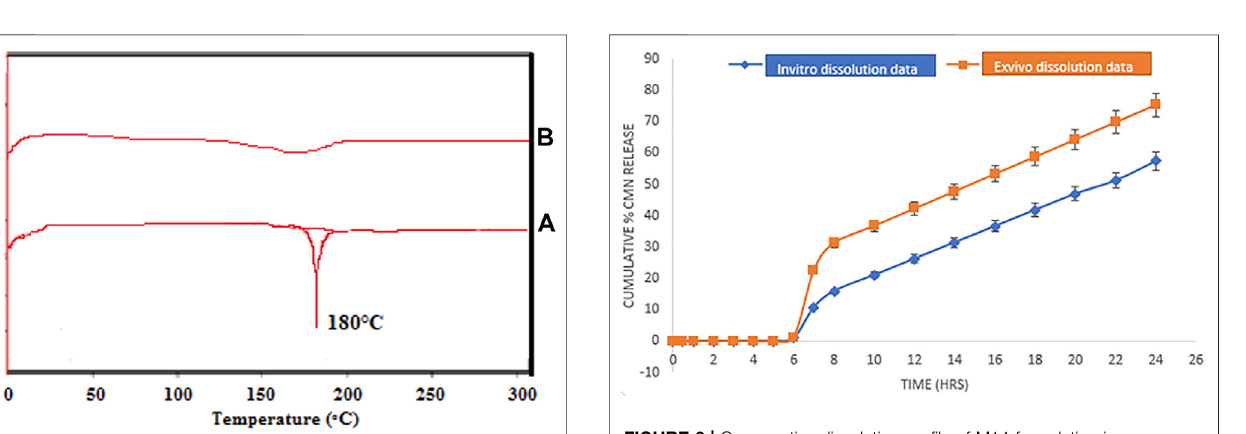
FIGURE 6 | Comparative dissolution pro fi le of M14 formulation in simulated GI fl uid pH buffer media ( in vitro dissolution data/drug release)